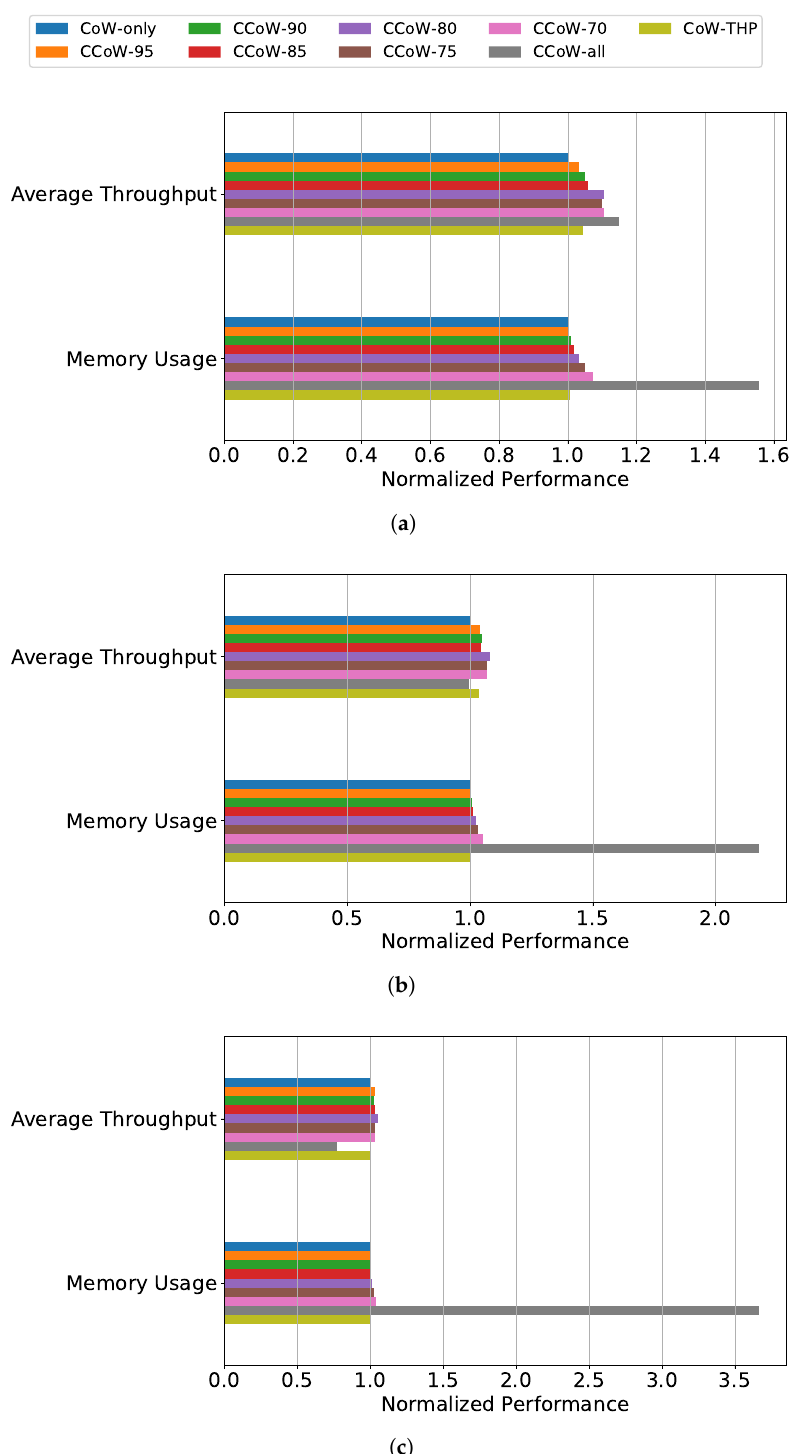
Figure 5. The performance and overhead of CCoW for various workload localities. ( a ) Low-locality workload ( α = 0.9). ( b ) Baseline ( α = 1.0). ( c ) High-locality workload ( α =